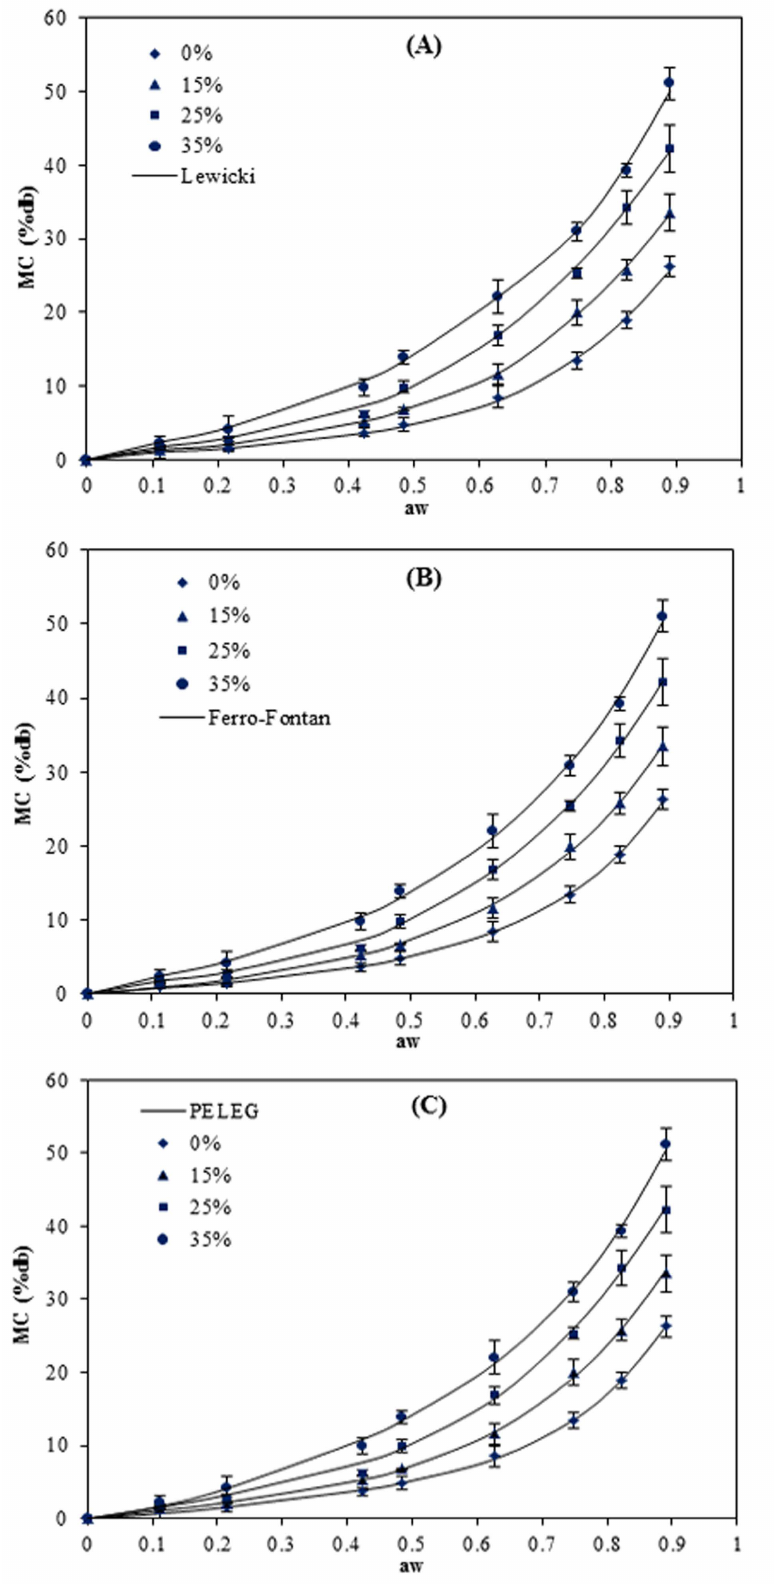
Figure 4. Equilibrium moisture sorption isotherm of pea starch film with different glycerol content ( w / w ) at 40 ˝ C. The symbols are experimental data and the lines are from the equations obtained by fitting the experimental data to Lewicki ( A ), Ferro–Fontan ( B ) and PELEG ( C )